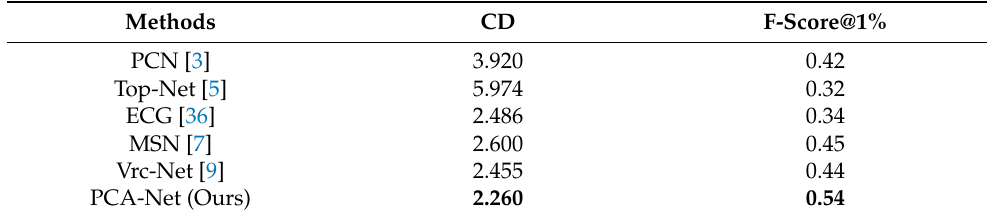
Table 3. Shape completion results ((CD × 10 3 ) and F − Score @1% ) on ModelNet40 point cloud dataset (2048